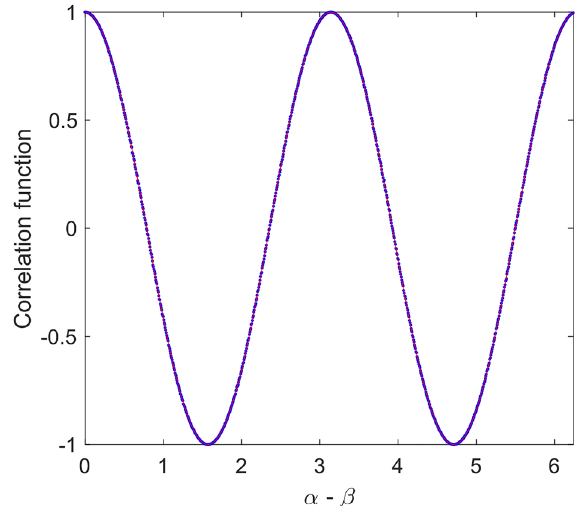
Figure 9. Simulation result of the correlation function. In this case polarizations of photons that hit second polarizer (B) are according to Eq. (23). As it is seen this correlation function completely agrees with quantum mechanics prediction.